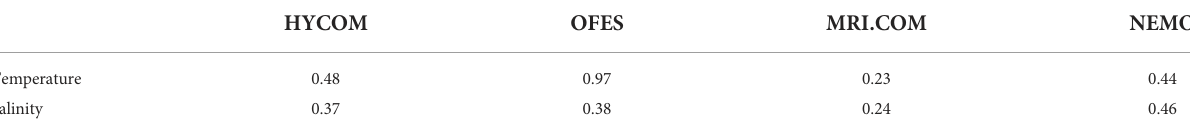
TABLE 2 Average cost function values for temperature and salinity based on Equation 2 for the ocean models HYCOM, OFES, MRI.COM, and NEMO.